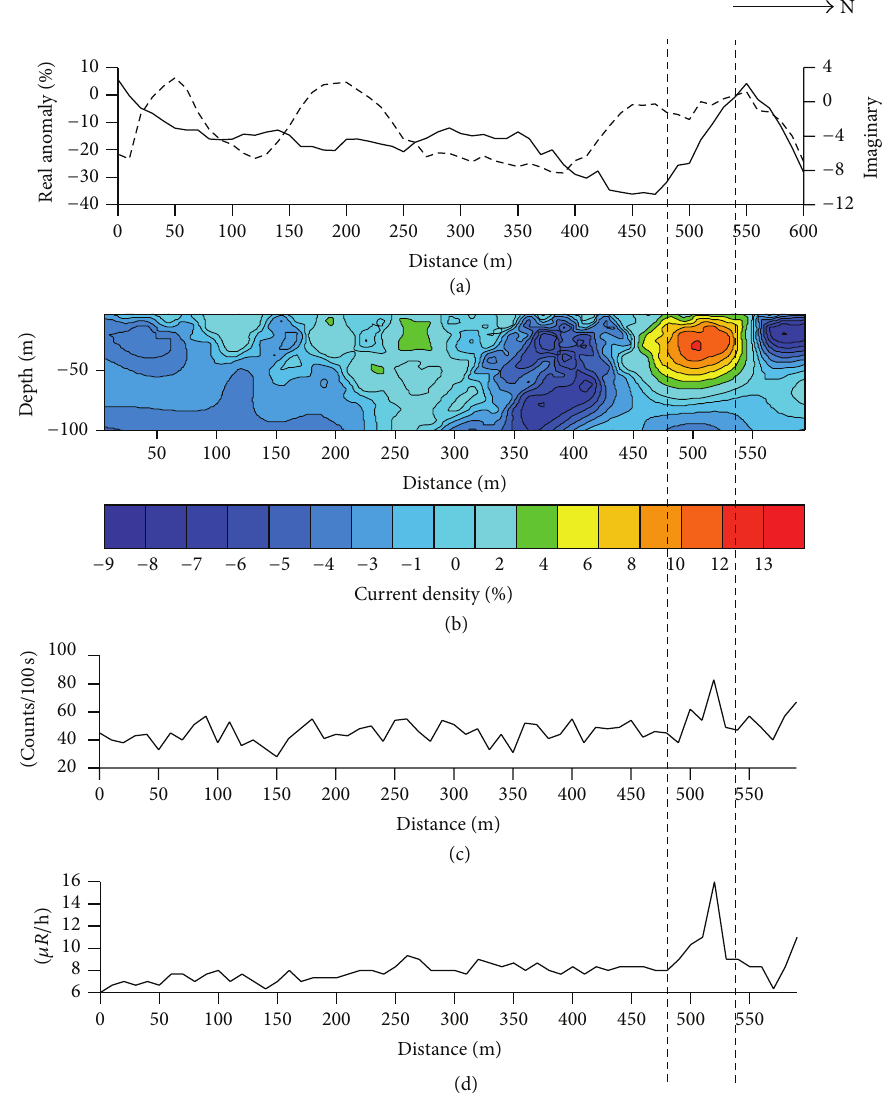
Figure 2: Profile P1100: (a) VLF anomaly (real by solid line and imaginary by dashed line), (b) pseudo current density cross-section along profile P1100, and (c) surface radiation and (d) surface gamma